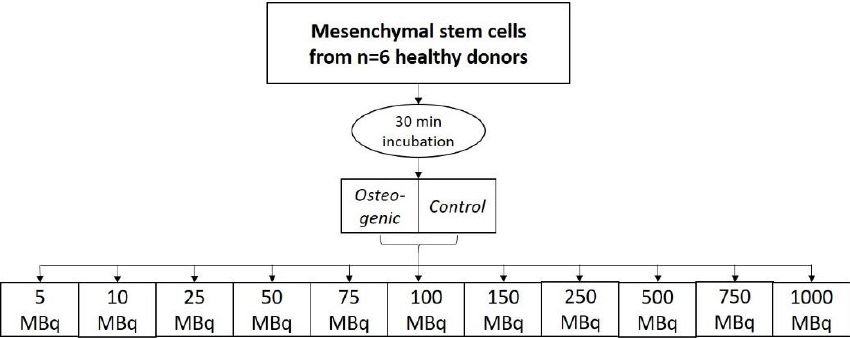
Figure 10. Study design for the 99m Tc-HDP saturation concentration evaluation.